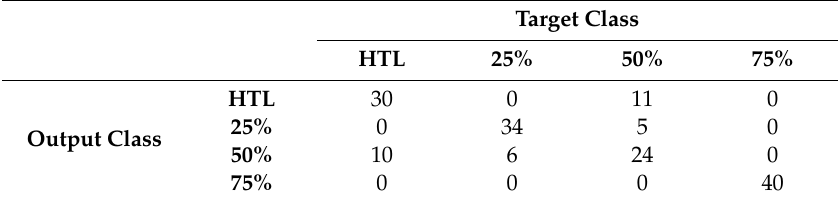
Table 7. Confusion matrix for the training of the ANN classifier with vibration signals.